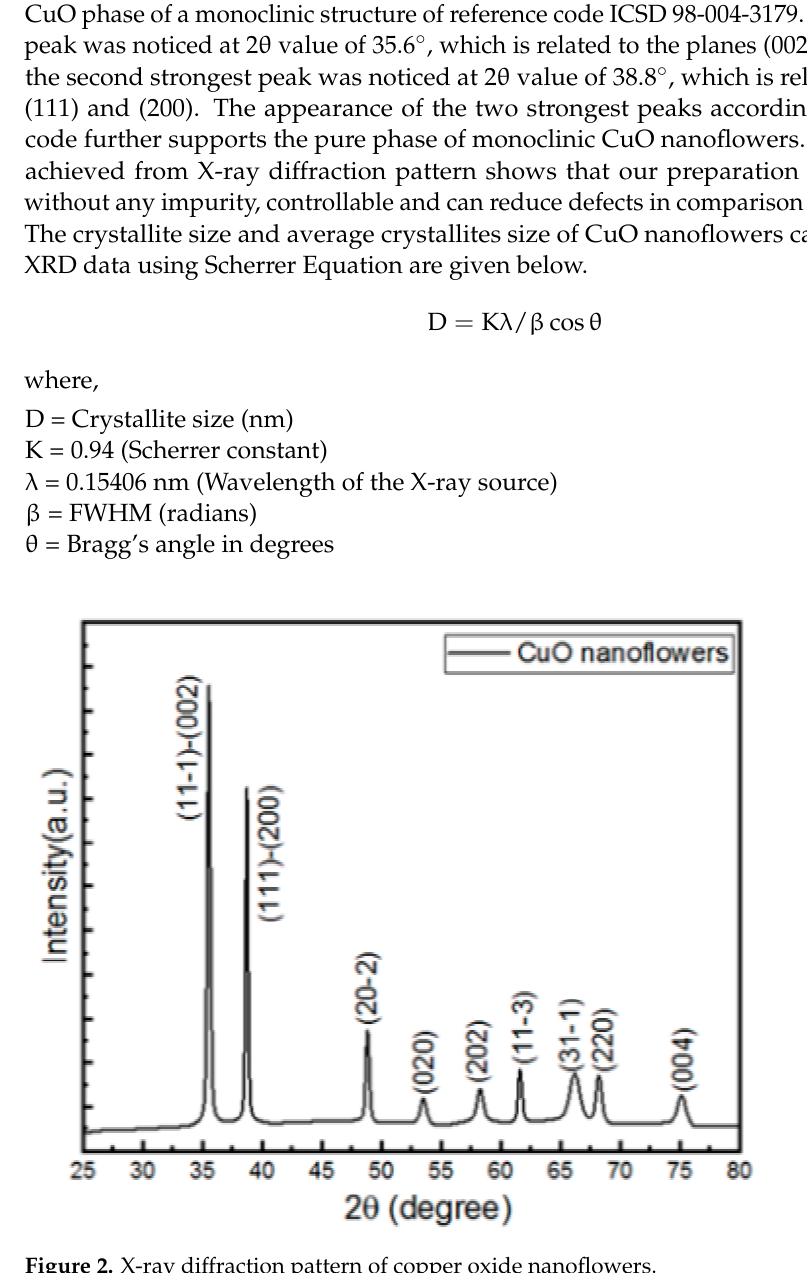
Figure 2. X-ray diffraction pattern of copper oxide nanoflowers.